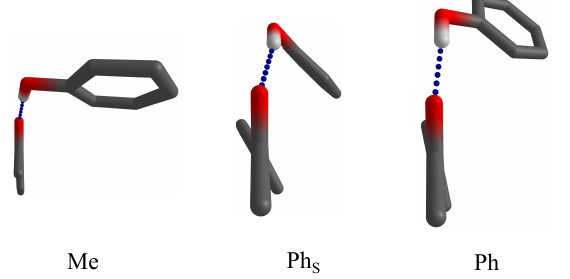
Figure 1. Docking variants for phenol on acetophenones (with the methyl group pointing toward the reader and the C=O group upwards). Methyl-side docking (Me) optimizes the hydrogen bond (blue dashes), whereas phenyl-side docking can either optimize the hydrogen bond (Ph) or phenyl stacking (Ph S ). The latter is sometimes assisted by a twist of the phenyl group in acetophenone. Acetophenone is well suited for vibrational spectroscopy because the mixed sp 2 /sp 3 substitution at the keto group allows for a different hydrogen bond angle due to donor oxygen interaction with the α -CH groups in the asymmetrically substituted ketone